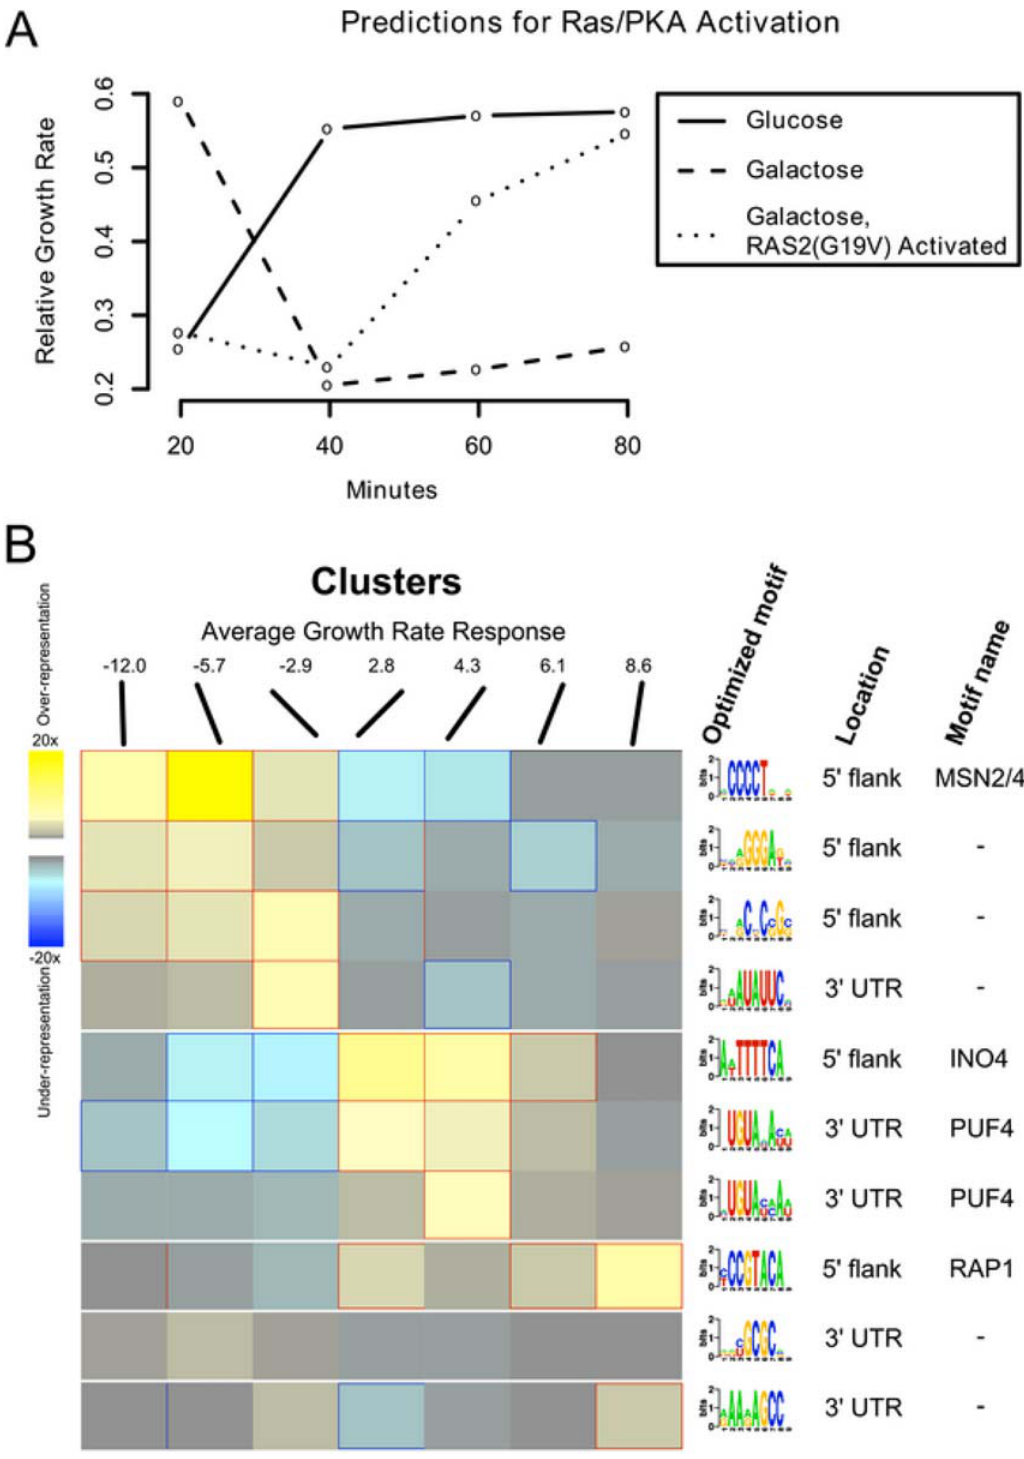
Figure 8. Perturbations and potential transcriptional regulators of the growth rate response. (A) Predicted growth rates for gal1 D cells shifted to glucose, to galactose, and to galactose with a constitutively active RAS2G19V allele. On glucose, rapid growth is induced within , 40 m; growth on galactose falls to low levels within , 40 m, as it cannot be metabolized by this mutant. However, when glucose sensing is emulated by artificial activation of the Ras/PKA pathway, the transcriptional regulatory network attempts to induce rapid growth within , 60–80 m despite the unavailability of appropriate nutrients. This disconnect between actual and perceived cellular state leads to cell death within 4–6 hours and suggests that nutrient sensing (as opposed to metabolic activity or internal cellular state) is responsible for a large portion of the transcriptional growth rate response. (B) Regulatory binding sites enriched in growth up- and down-regulated genes. We clustered the yeast genome by degree of growth rate response, yielding ten clusters with average responses ranging from 2 12.0 (strongly downregulated with increasing growth rate) to 8.6 (strongly upregulated). The FIRE program [34] predicted 10 regulatory motifs in the upstream flanks and 3 9 UTRs of the most up- and down-regulated clusters. These included the known stress-responsive MSN2/4 binding sites in downregulated genes, the ribosomal regulators RAP1 and PUF4 in upregulated genes, and INO4 sites in upregulated genes (possibly corresponding to its role in the stress response and fatty acid biosynthesis [35]. We also identified five additional putative growth regulatory sites for which the binding factor is not yet known.